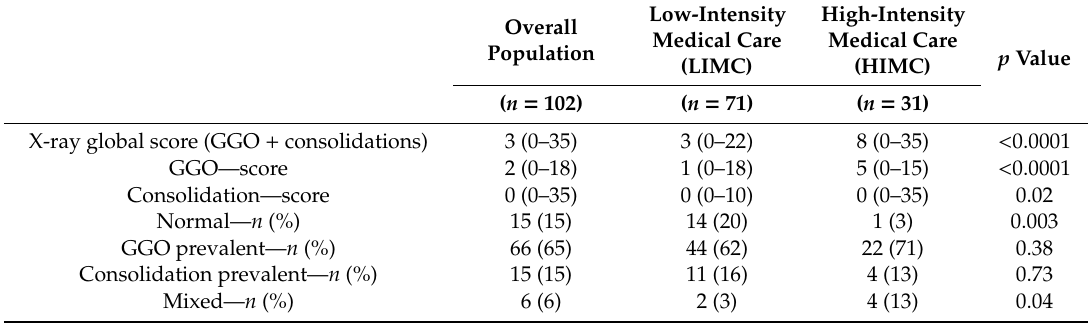
Table 2. Baseline radiological scores of the overall population hospitalized for SARS-CoV-2 related infection, and of the two subgroups categorized in low (LIMC) and high (HIMC) intensity medical care. High-Intensity Low-Intensity Overall Medical Care Medical Care Population (HIMC) p Value (LIMC) ( n = 102) ( n = 71) ( n = 31) X-ray global score (GGO + consolidations) 3 (0–35) 3 (0–22) 8 (0–35) < 0.0001 GGO—score 2 (0–18) 1 (0–18) 5 (0–15) < 0.0001 0 (0–35) GGO prevalent— n (%) 66 (65) 44 (62) 22 (71) 0.38 Consolidation prevalent— n (%) 15 (15) 11 (16) 4 (13) 0.73 Mixed— n (%) 6 (6) 2 (3) 4 (13)